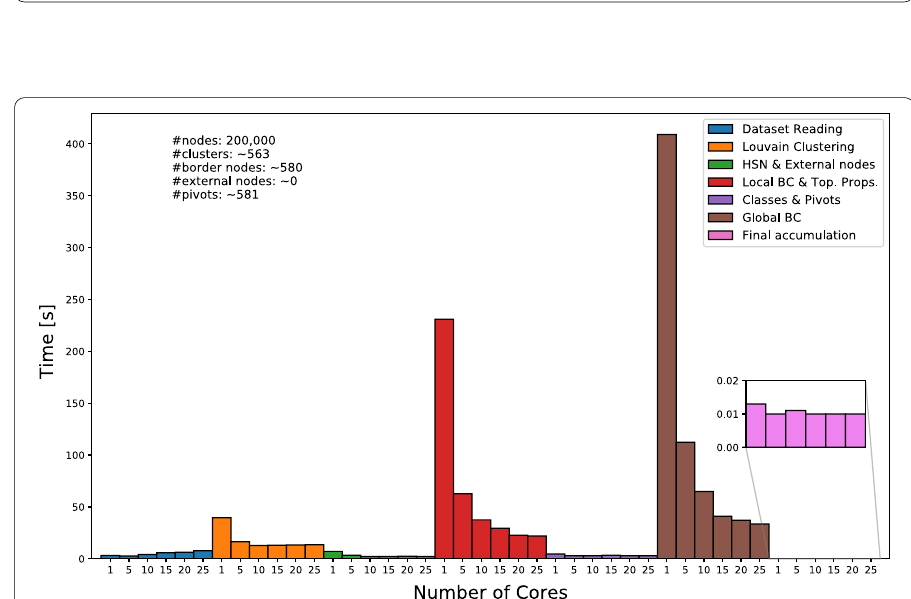
Fig. 14 Breakdown analysis of computation time on synthetic graph with 200,000